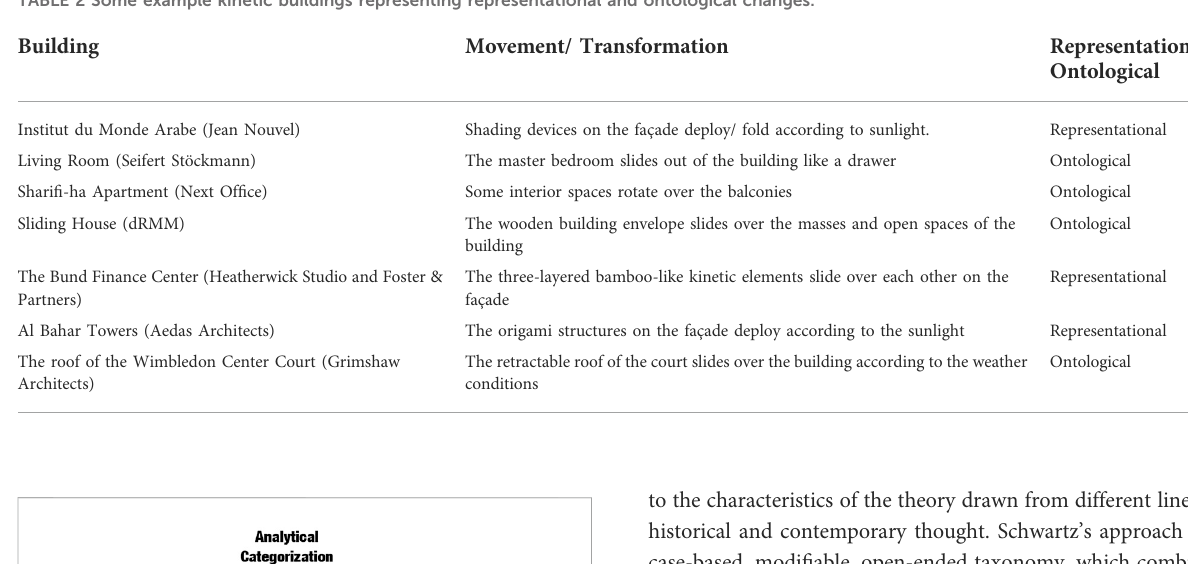
TABLE 2 Some example kinetic buildings representing representational and ontological changes.